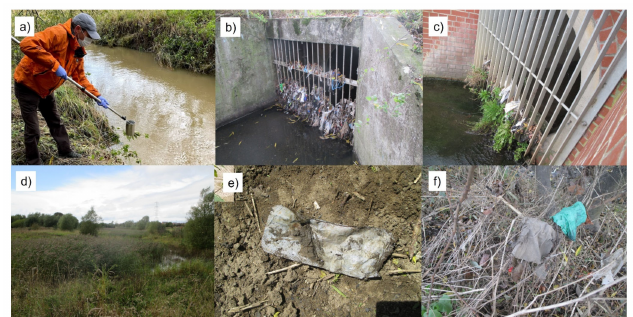
Figure A1. ( a ) Sampling the Ouseburn River upstream of the storm drains; ( b ) Kingston Park storm drain; ( c ) Great Park storm drain; ( d ) stormwater retention ponds at Great Park; ( e , f ) sewage litter and other plastic flotsam in the Ouseburn embankment downstream of the Kingston Park storm drain. Table A1. DNA yield, 16S rRNA, and rodA gene copies for the different extraction methods and qPCR instruments, showing the data for each filter replicate. qPCR results are the average and standard deviation of duplicate analysis from each DNA extract, * means significant at p <